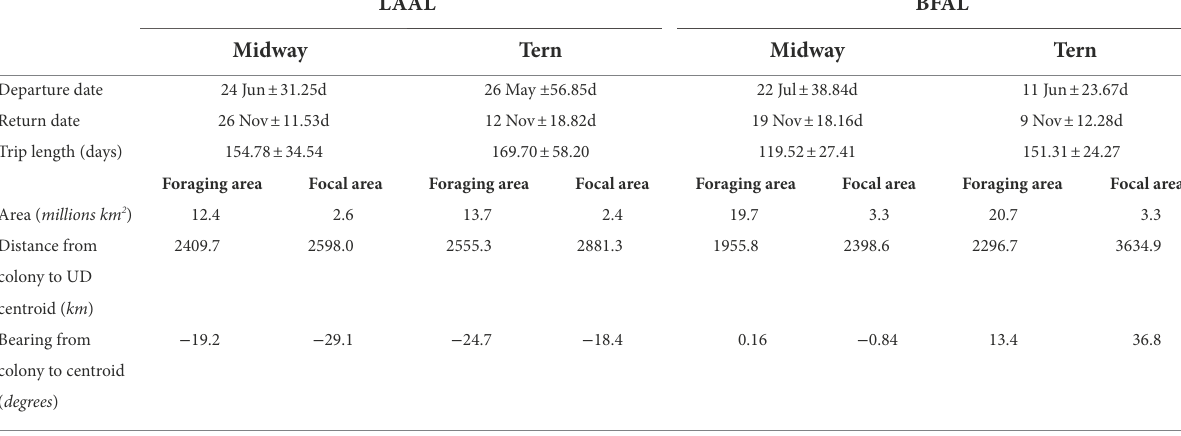
TABLE 3 Summary trip characteristics of departure date, return date, trip length, area of focal and foraging areas, distance from colony to the centroid of the focal and foraging areas, and bearing from the colony to the centroid of the focal and foraging areas by species (LAAL = Laysan albatross; BFAL = black-footed albatross) and breeding colony for both foraging and focal areas (represented by the 95 and 50th utilization distribution,